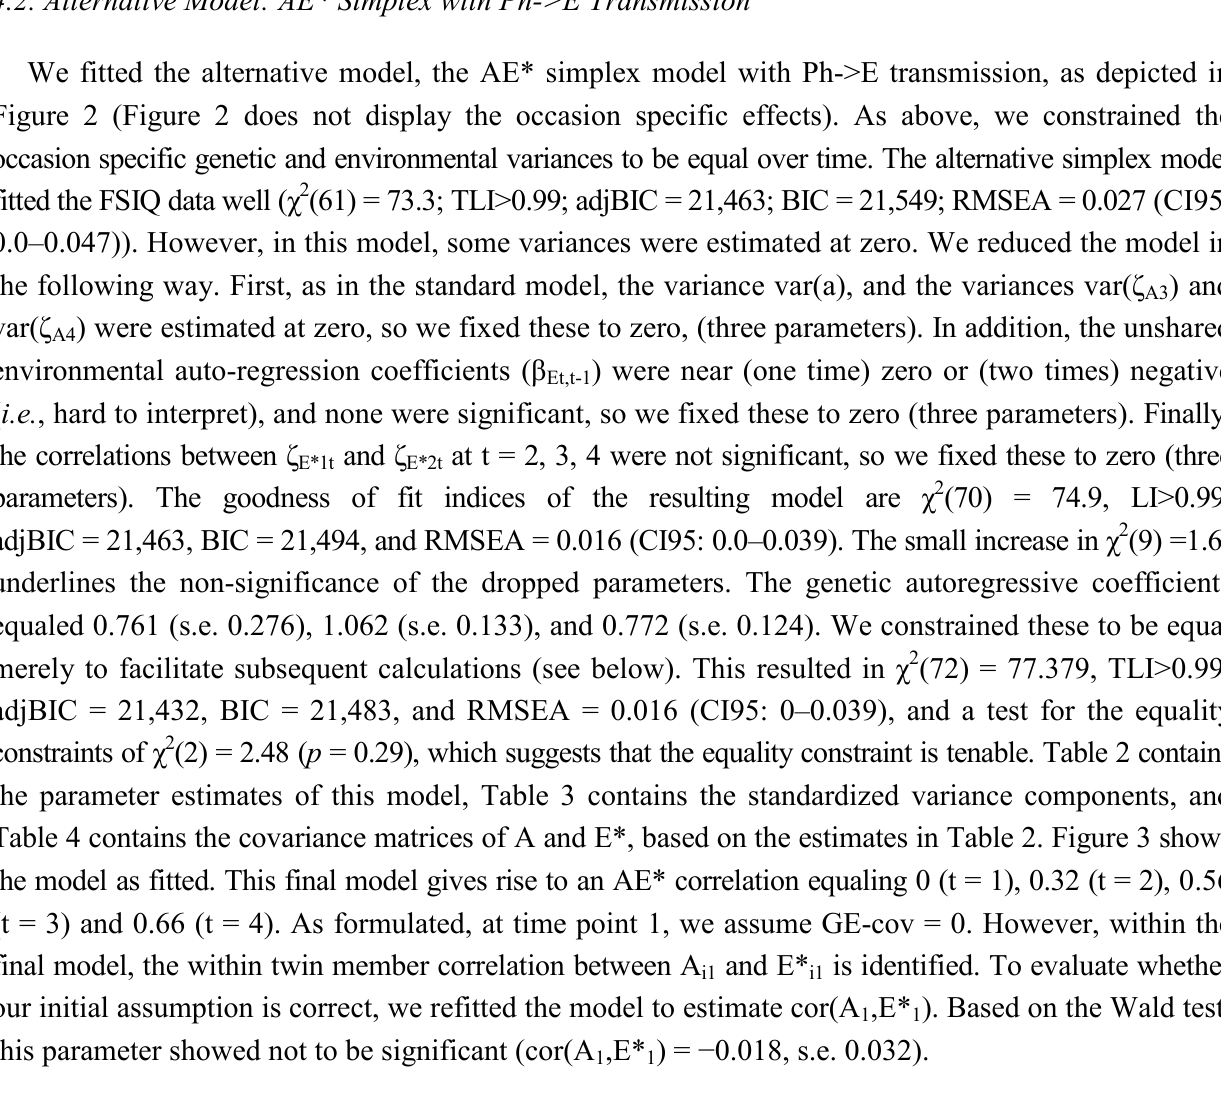
Table 2. FIML parameters and standard errors (s.e.) of the AE* model with Ph->E transmission as fitted to FSIQ and perfIQ. 0* indicates that the parameter value was fixed to